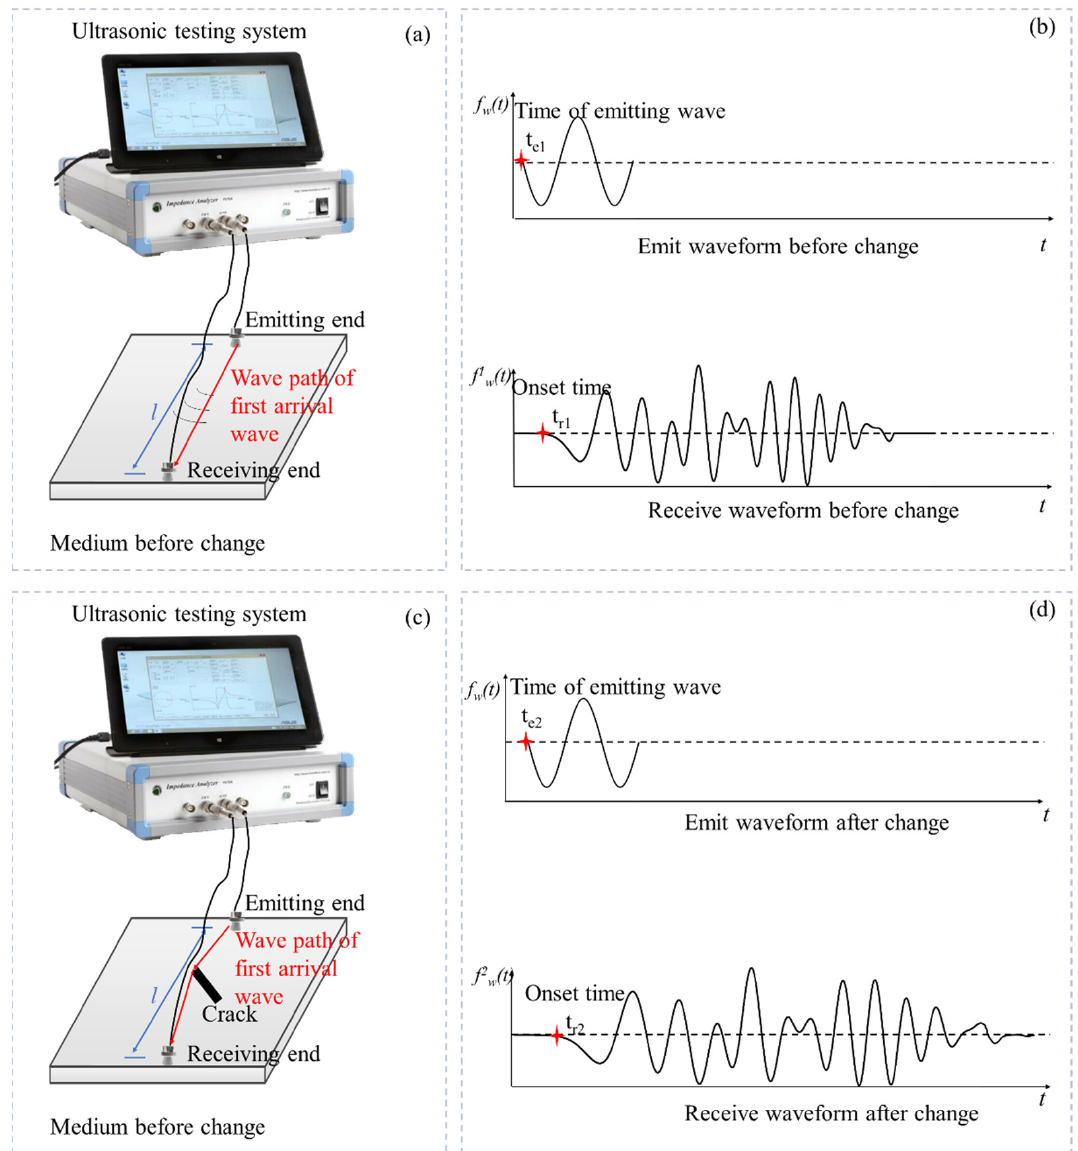
Figure 1. ( a ) The ultrasonic testing system and medium before the change; ( b ) the emitted and received waveform before the change; ( c ) the ultrasonic testing system and medium after the change; ( d ) the emitted and received waveform after the change.